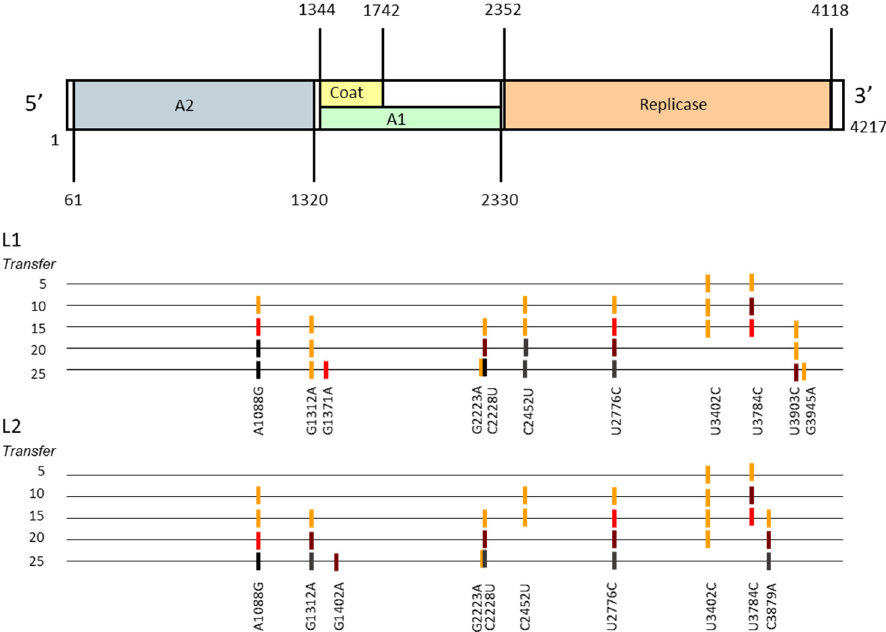
Figure 2. Location in the Q β genome of the mutations present in the consensus sequences of lineages L1 and L2, propagated at 43 ◦ C for different number of transfers. The upper part of the figure shows a scheme of the Q β genome with the position of its four genes. The following colour notation was used to indicate the relative abundance of the mutated (M) and wild-type nucleotide (WT): orange (M < WT), red (M = WT), brown (M > WT), and black (the mutation is fixed) (see Materials and